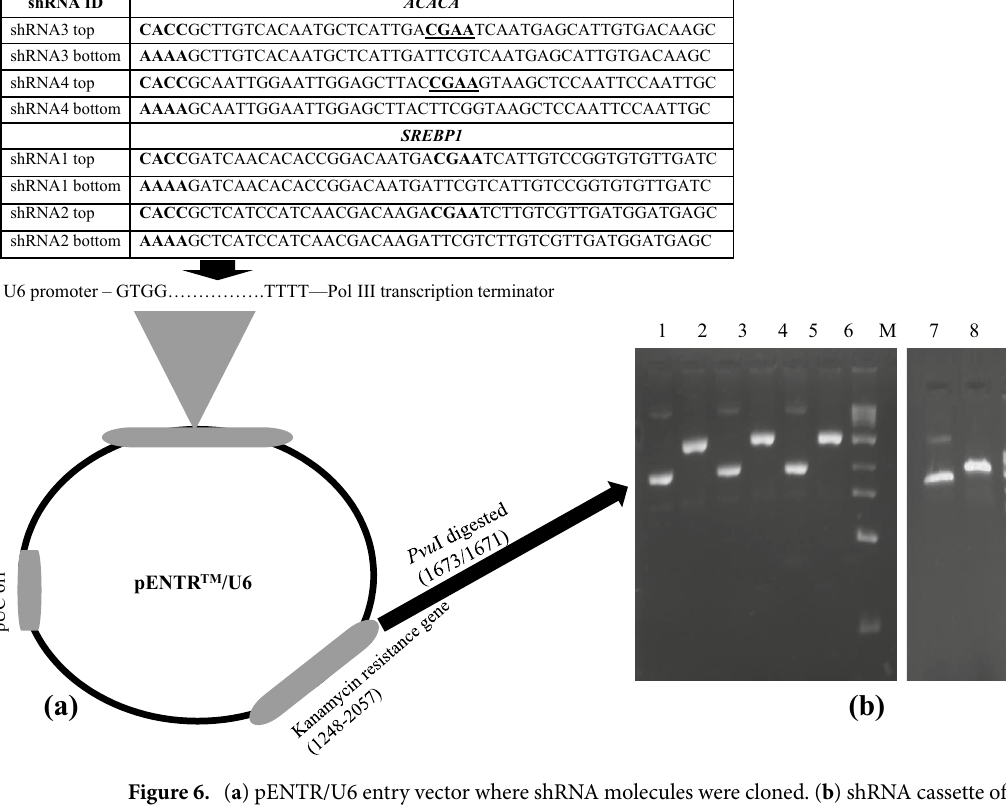
Sperm mediated gene transfer (SMGT).